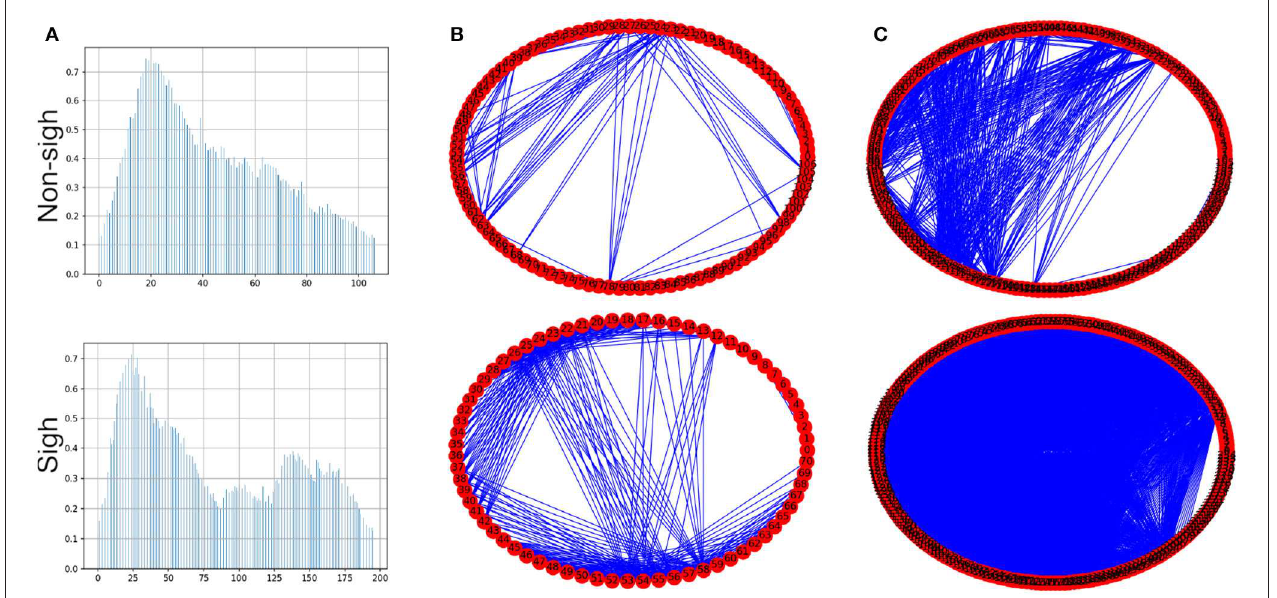
FIGURE 6 | (A) Inspiratory burst recordings with its sampling frequency reduced to 5 % of non-sigh and sigh time series from respiratory rhythm in vitro recordings. (B) Circle visibility graphs constructed from time series shown in (A) , for non-sigh G 1 and sigh G 2 , respectively. The non-sigh circle visibility graph may appear to show fewer connections than the sigh one. (C) Maxclique graphs for non-sigh and sigh. In this case, it is apparent that the number of connections (that is, edges) is much larger for sigh ( K ( G 2 )) than non-sigh ( K ( G 1 )).